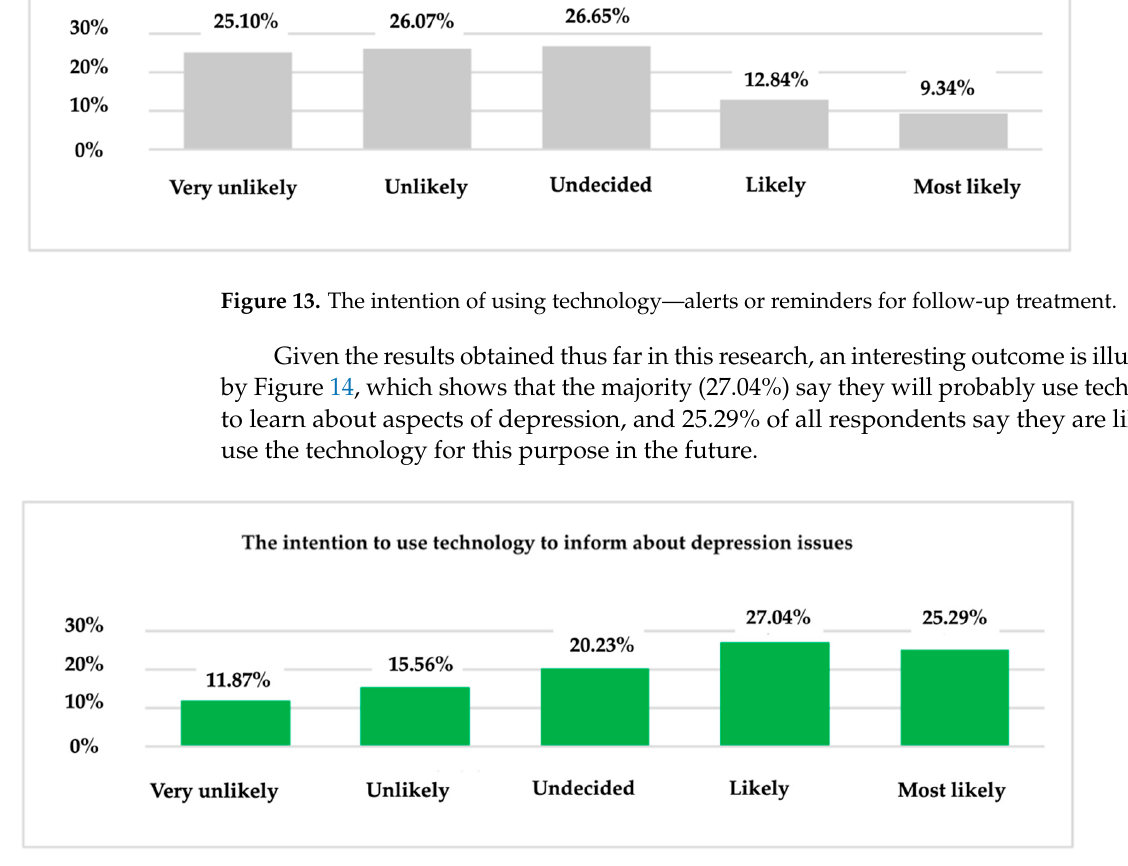
Figure 14. The intention of using technology—information about depression issues.